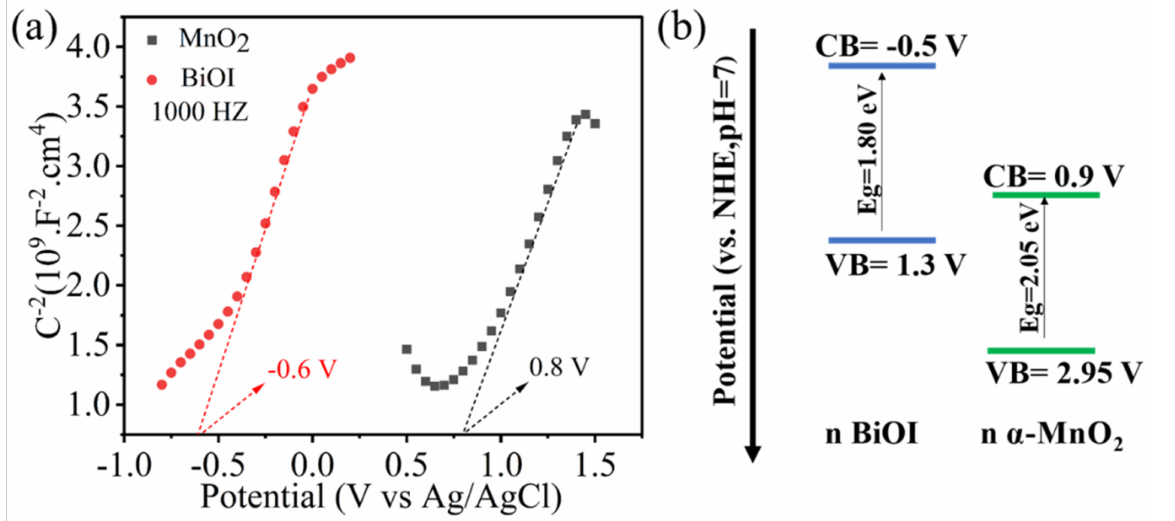
Figure 15. ( a ) Mott–Schottky plots of α -MnO 2 and BiOI; ( b ) energy band structure of α -MnO 2 and